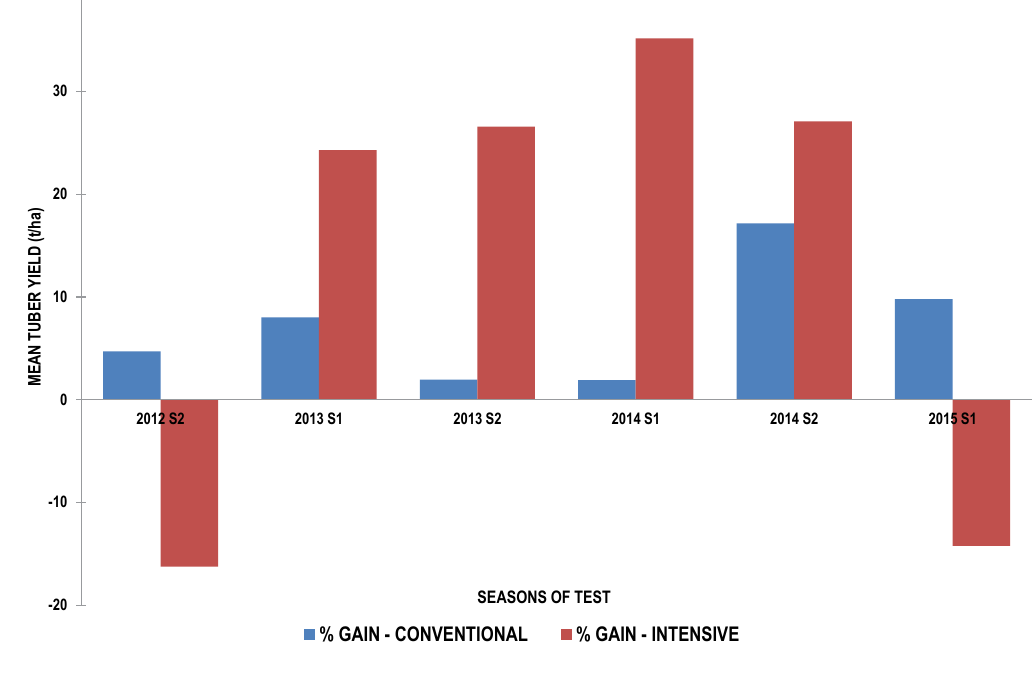
Figure 4: Mean tuber yield of checks in conventional and intensive NPT